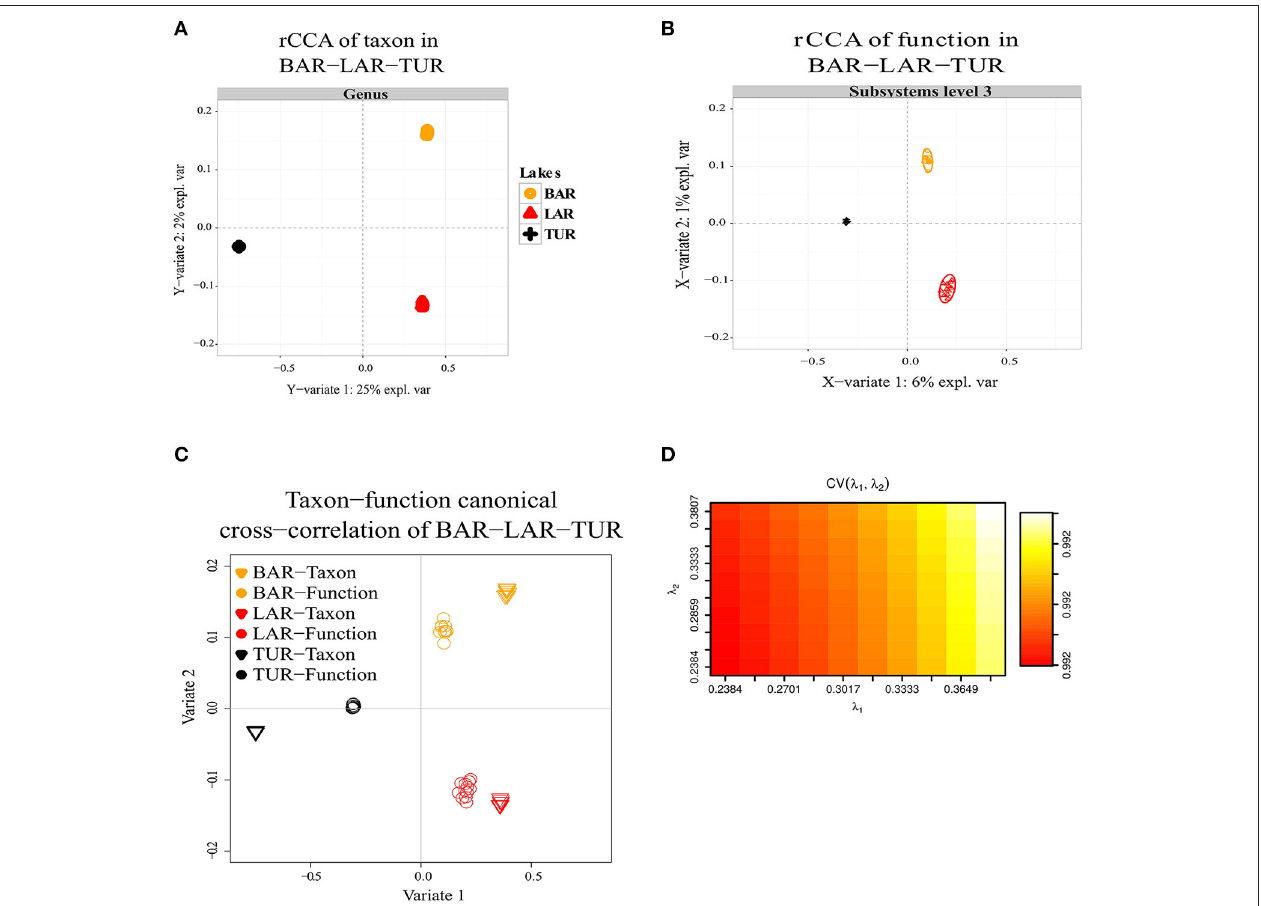
FIGURE 5 | Decoupling of taxon and function between metacommunities based on the subsampled reads approach. (A–D) Regularized canonical correlation analysis (rCCA) performed on BAR-mc, LAR-hc, and TUR-hc. (A) rCCA of a taxon (relative genus abundance) showed 25% of the explained variance on the first canonical component. (B) rCCA of function (subsystems level3 relative abundance) showed only 6% of the explained variance on the first canonical component. (C) The canonical cross-correlation of taxon-function identified a decoupling pattern. (D) Cross-validation score converged to a maximum value of 0.99 when regularization parameters λ 1 and λ 2 were both fixed at